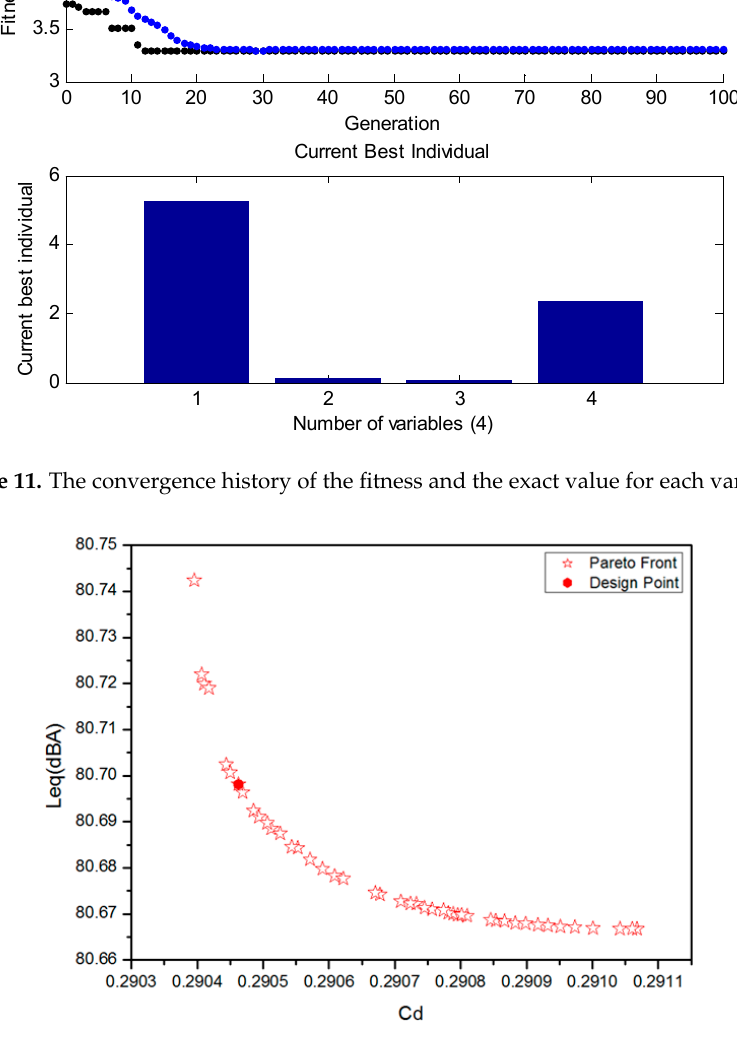
Figure 11. The convergence history of the fitness and the exact value for each variable.